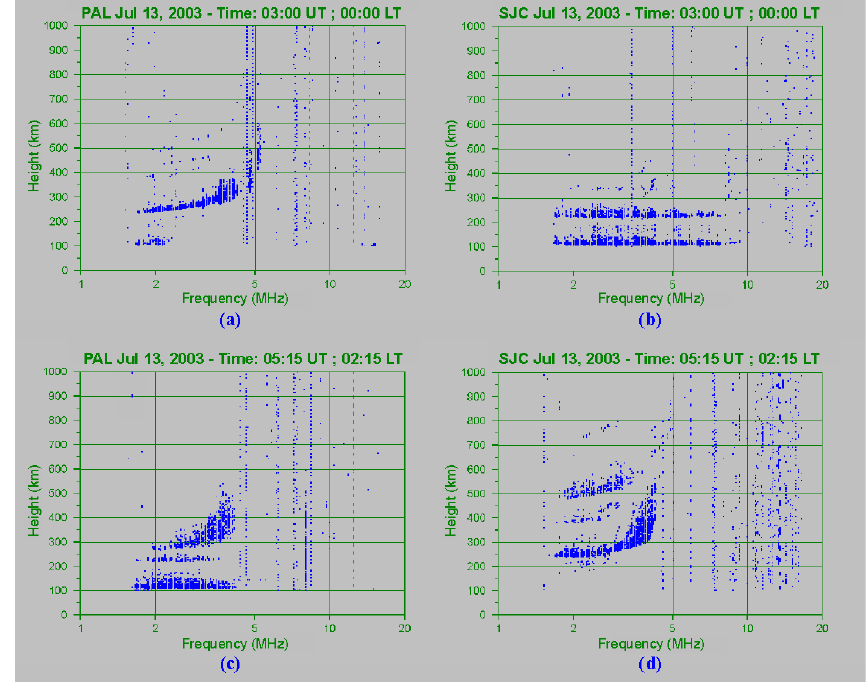
Fig. 6. Examples of ionograms obtained at Palmas and Sao Jose dos Campos on the night of 12–13 July